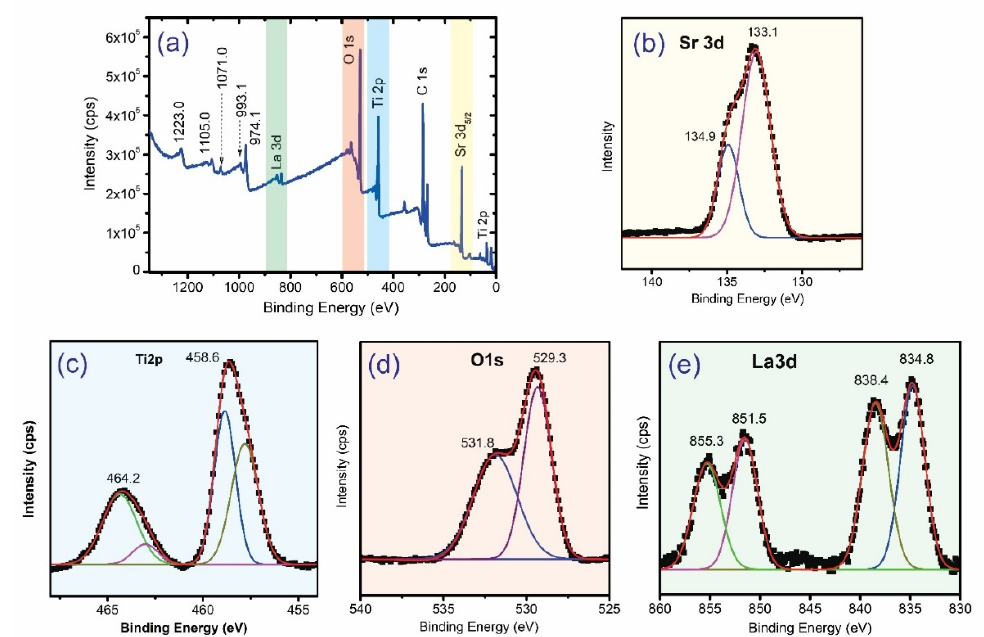
Figure 5. XPS spectra of Sr 0.95 La 0.05 TiO 3 : ( a ) full spectra, ( b ) Sr 3d, ( c ) Ti 2p, ( d ) O and ( e ) La 3d spectra.